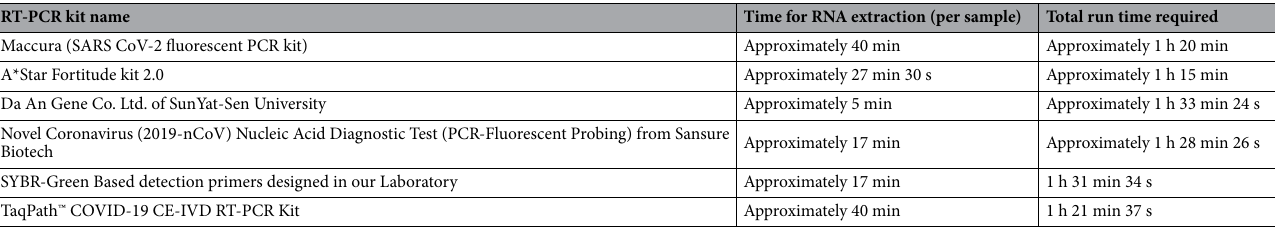
Table 1. Total run time required for completing a full RT-PCR